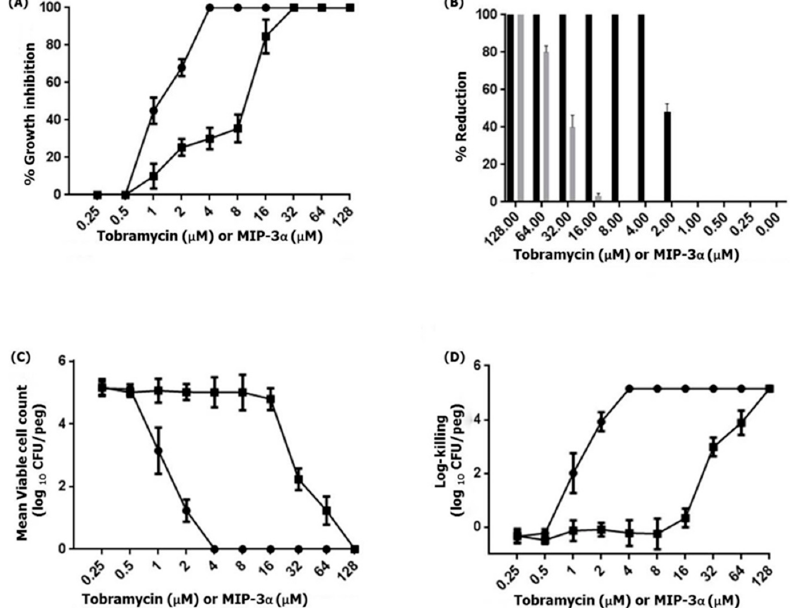
Figure 6. ( A ) The MBIC of tobramycin (circles) or MIP-3 α (squares) was determined by the standard crystal violet assay for the quantification of growth inhibition. ( B ) The MBRC of tobramycin (black) or MIP-3 α (gray) was determined by an assay with crystal violet, and percentage reduction of